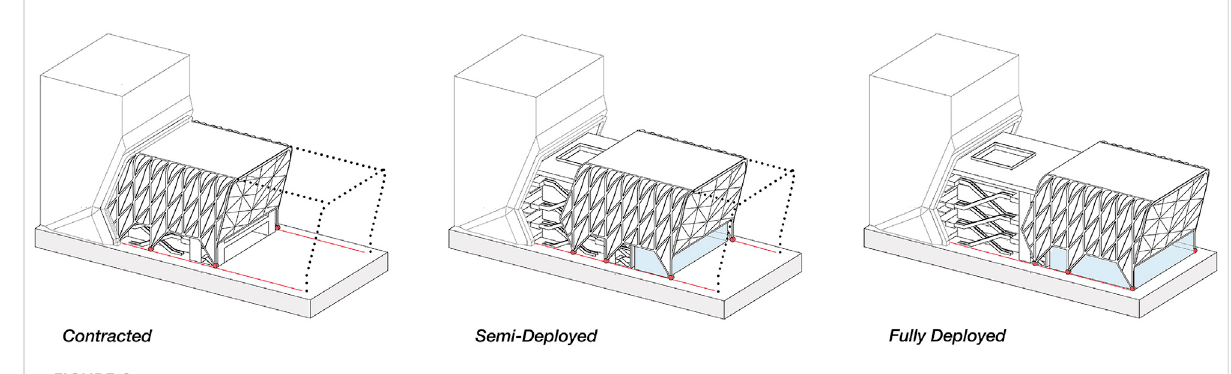
FIGURE 8 Deployment of the Envelope (drawn by the